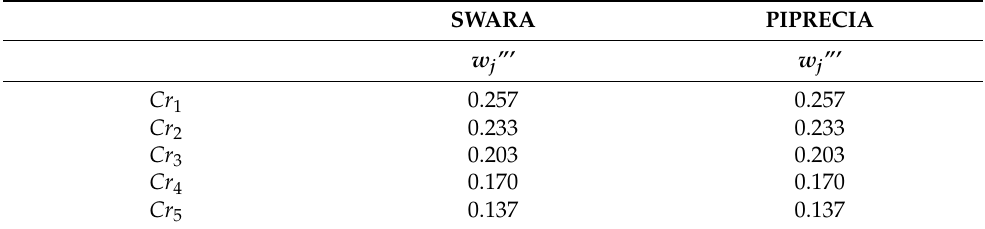
Table 12. The comparison of criteria weight obtained using the SWARA and PIPRECIA